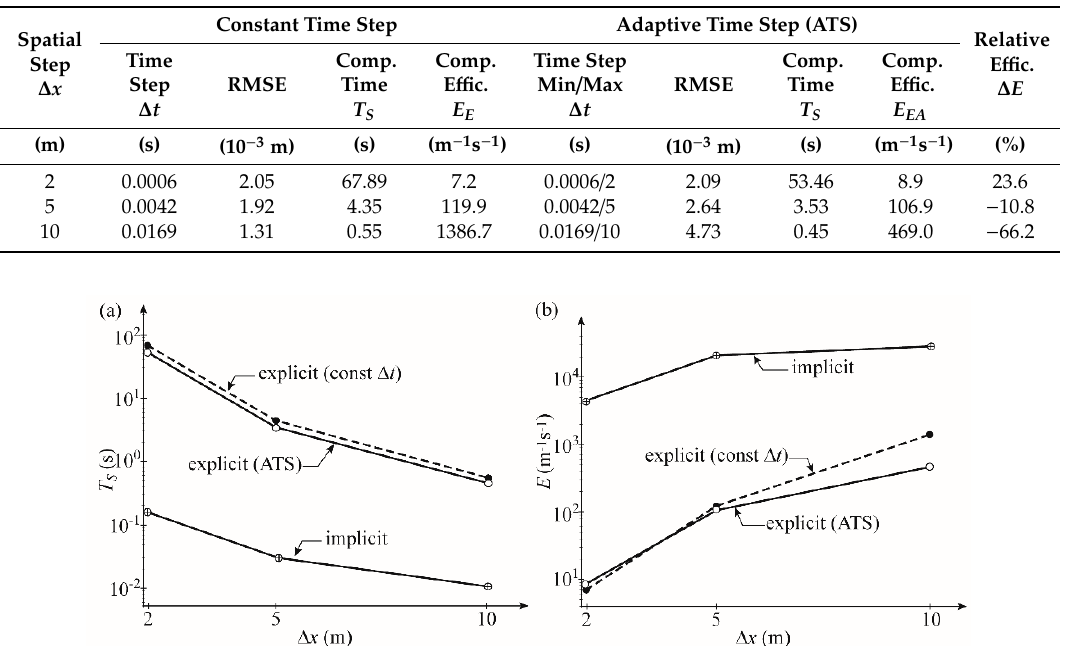
Figure 7. Dependence of the time step length on the simulation time for the ATS method: linear scale ( a ), logarithmic scale ( b ).